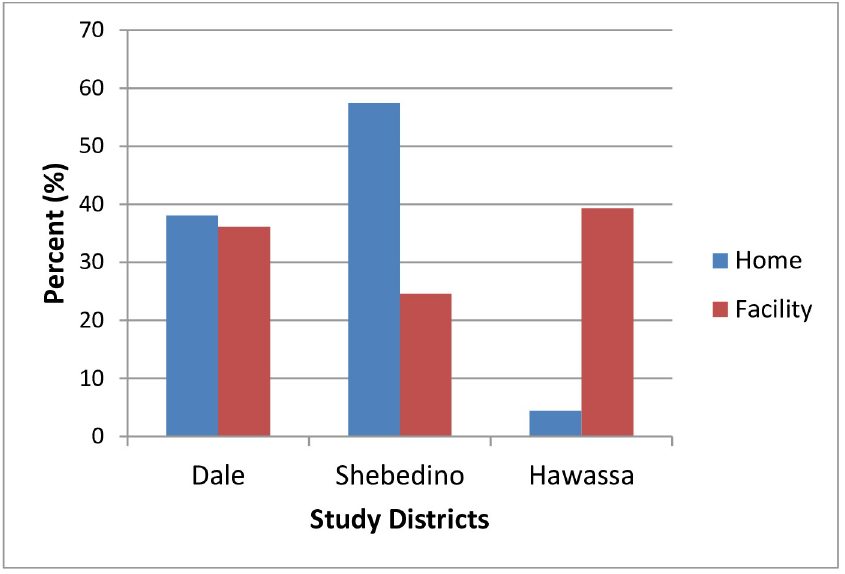
Fig 1. Place of delivery cross tabulated by the study districts, Sidama Administration, 2018.